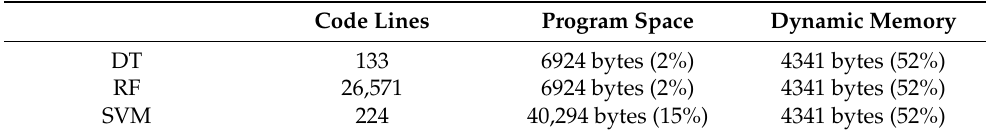
Table 6. Impact of the models on Arduino